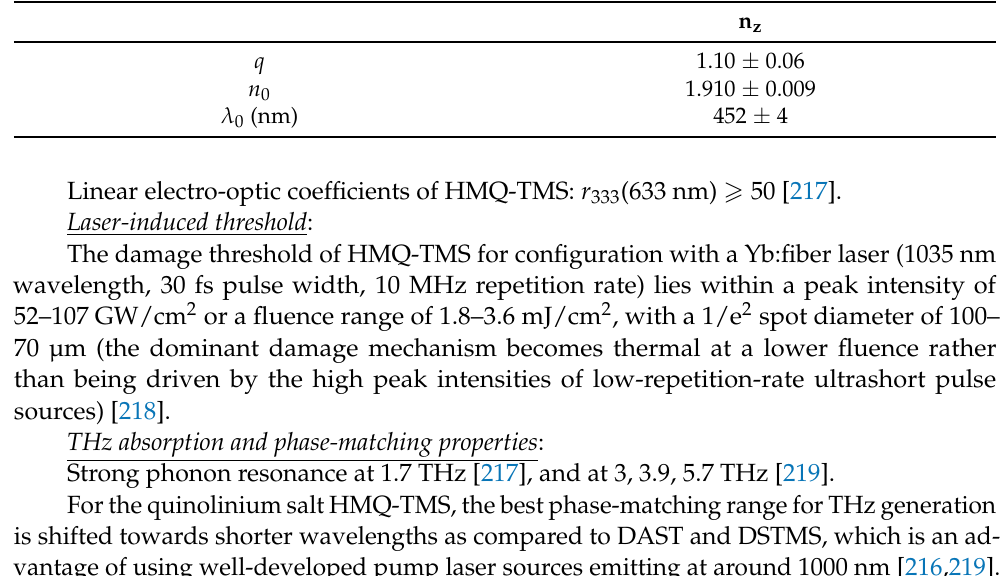
Table 20. Sellmeier parameters for the refractive index dispersion of Equation (26)